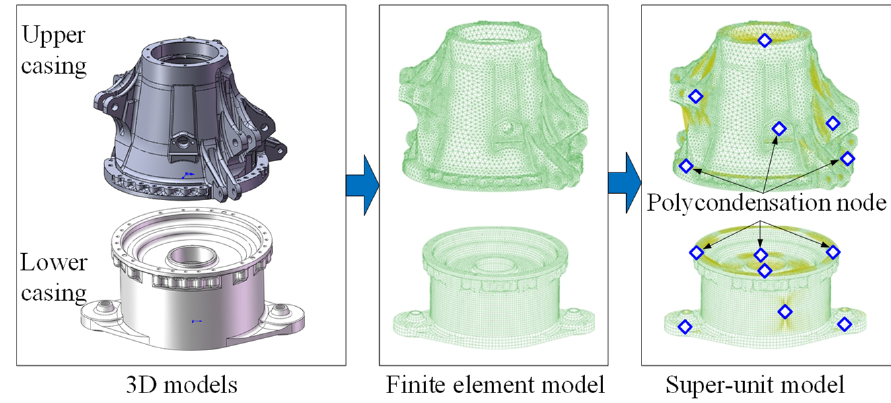
Table 1. Material properties of the casing.